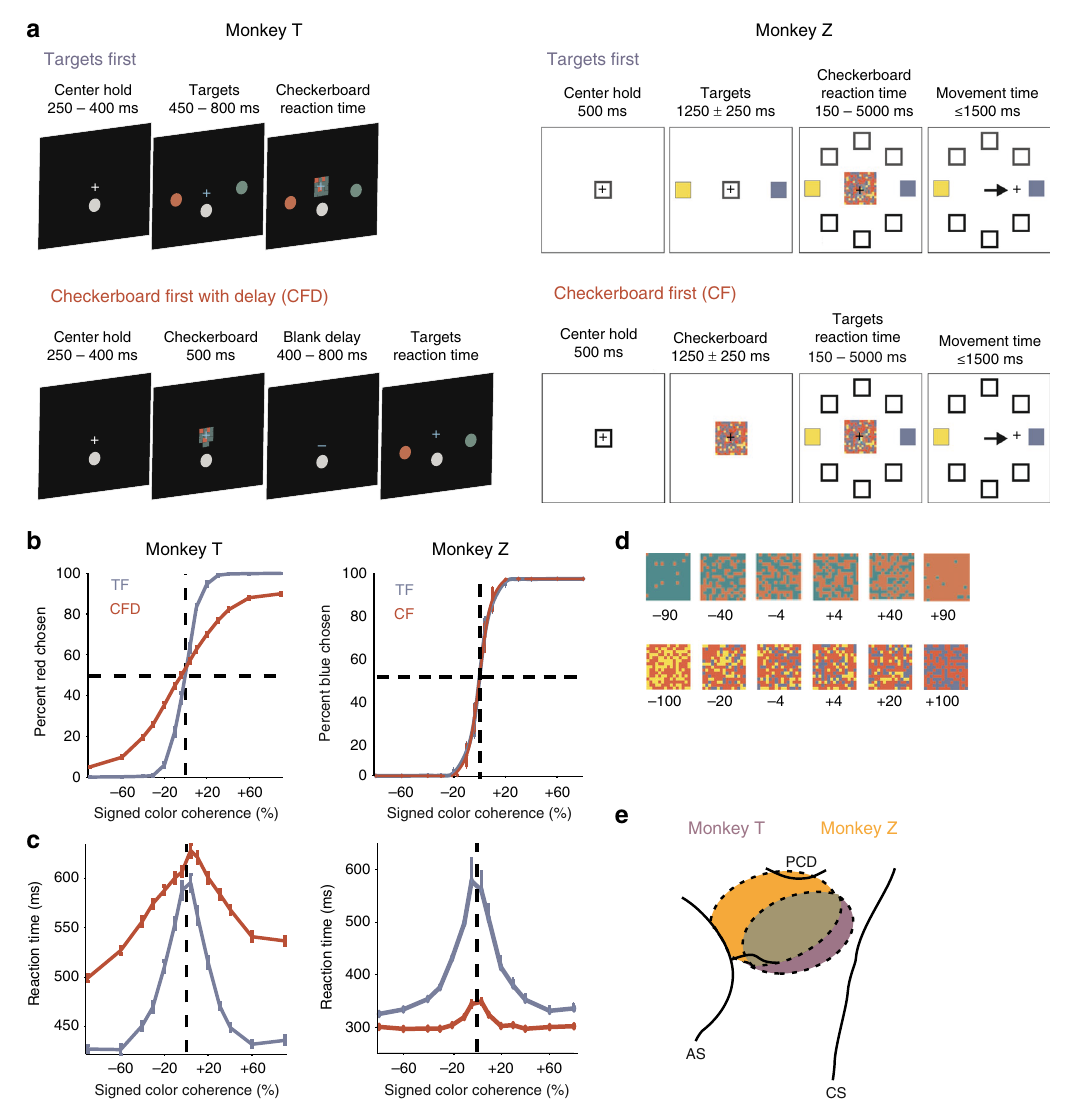
Fig. 1 Choice behavior of two monkeys (T and Z) in the Targets First(TF) and Checkerboard First (CF) tasks. a Two monkeys from two labs performed variants of a checkerboard color discrimination task. The TF task design (top row) follows the usual convention of presenting possible action choices — here, colored targets — before a decision cue — here, a colored checkerboard. The goal is to report the dominant color of the checkerboard by reaching to the corresponding colored target. Note that in this design, perceptual decision-making (checkerboard color discrimination) and action selection (choosing and reaching to the target with the matching color) both occur in the reaction-time interval between checkerboard onset and movement onset, and in theory can happen simultaneously. In the CF and CF with Delay (CFD) task design (bottom row), the order of presentation is reversed to dissociate perceptual decision-making and action selection. Target color identities are assigned randomly on each trial. b Psychometric curves of the probability of red (T) or blue (Z) target color choices (mean ± s.e.m.) as a function of signed checkerboard color coherence (see ( d ) for examples). As the strength of color evidence in the checkerboards supporting a reach to a red/blue target increased, the probability of reaches to those colored targets increased. c Chronometric curves of reaction times (RTs; mean ± s.e.m.) as a function of signed checkerboard color coherence. As the strength of color evidence in the checkerboard increased, RT durations tended to decrease. See also Supplementary Figure 1. d Examples of red-green checkerboards for T (top row) and blue-yellow checkerboards for Z (bottom row), labeled with their level of signed color coherence (units are %). e Recordings were performed in dorsal premotor cortex (PMd) in the hemisphere contralateral to the reaching arm. Data include units recorded from single electrodes and linear arrays. This schematic map illustrates the approximate locations of recording sites based on stereotactic coordinates. Histology has not yet been done on either monkey.